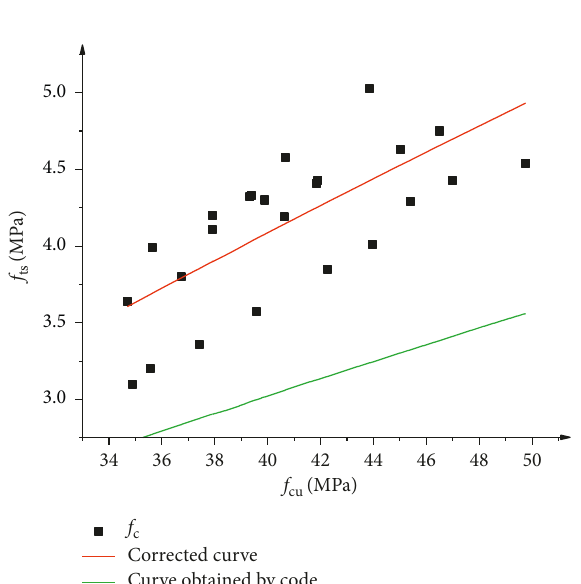
Figure 10: Curves of equation.